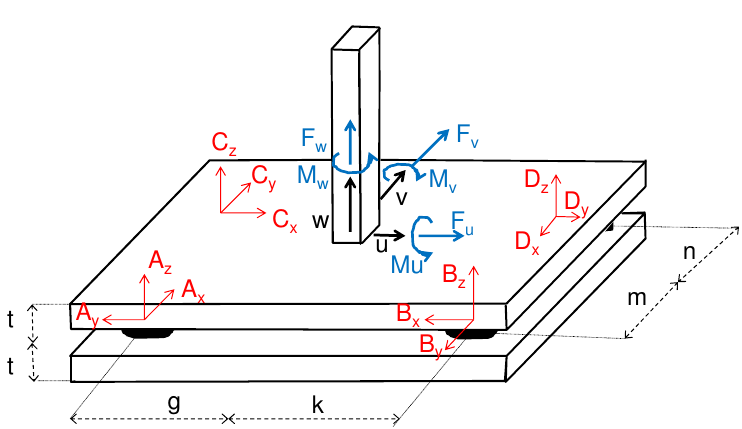
Figure 11. Orientation and position of local coordinate systems x , y , z of single load cells with respect to the chosen global coordinate system u , v , w . Also shown are the directions of the internal torques M u , M v , M w and forces F u , F v , F w between the steel post and the measurement plate.